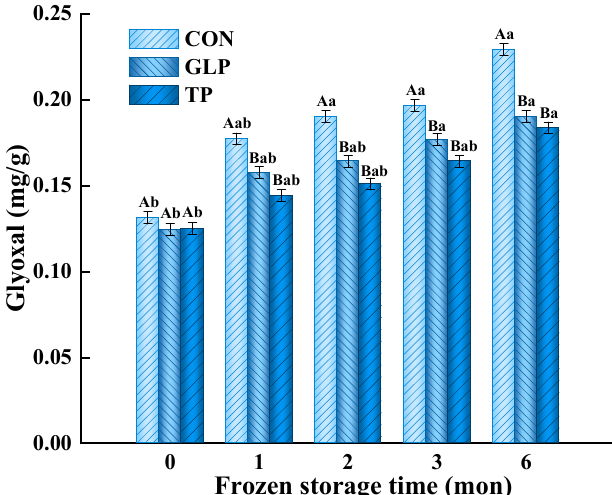
Figure 3. Effect of guava leaf polyphenols on the glyoxal content of frozen chicken meatballs. GLP, guava leaf polyphenols; TP, tea polyphenol; CON, control. The means at the same frozen storage with different uppercase letters (A,B) differ significantly ( p < 0.05); the means at the same polyphenols processing with different lowercase letters (a,b) differ significantly ( p < 0.05). The results are means ± SE ( n = 3).